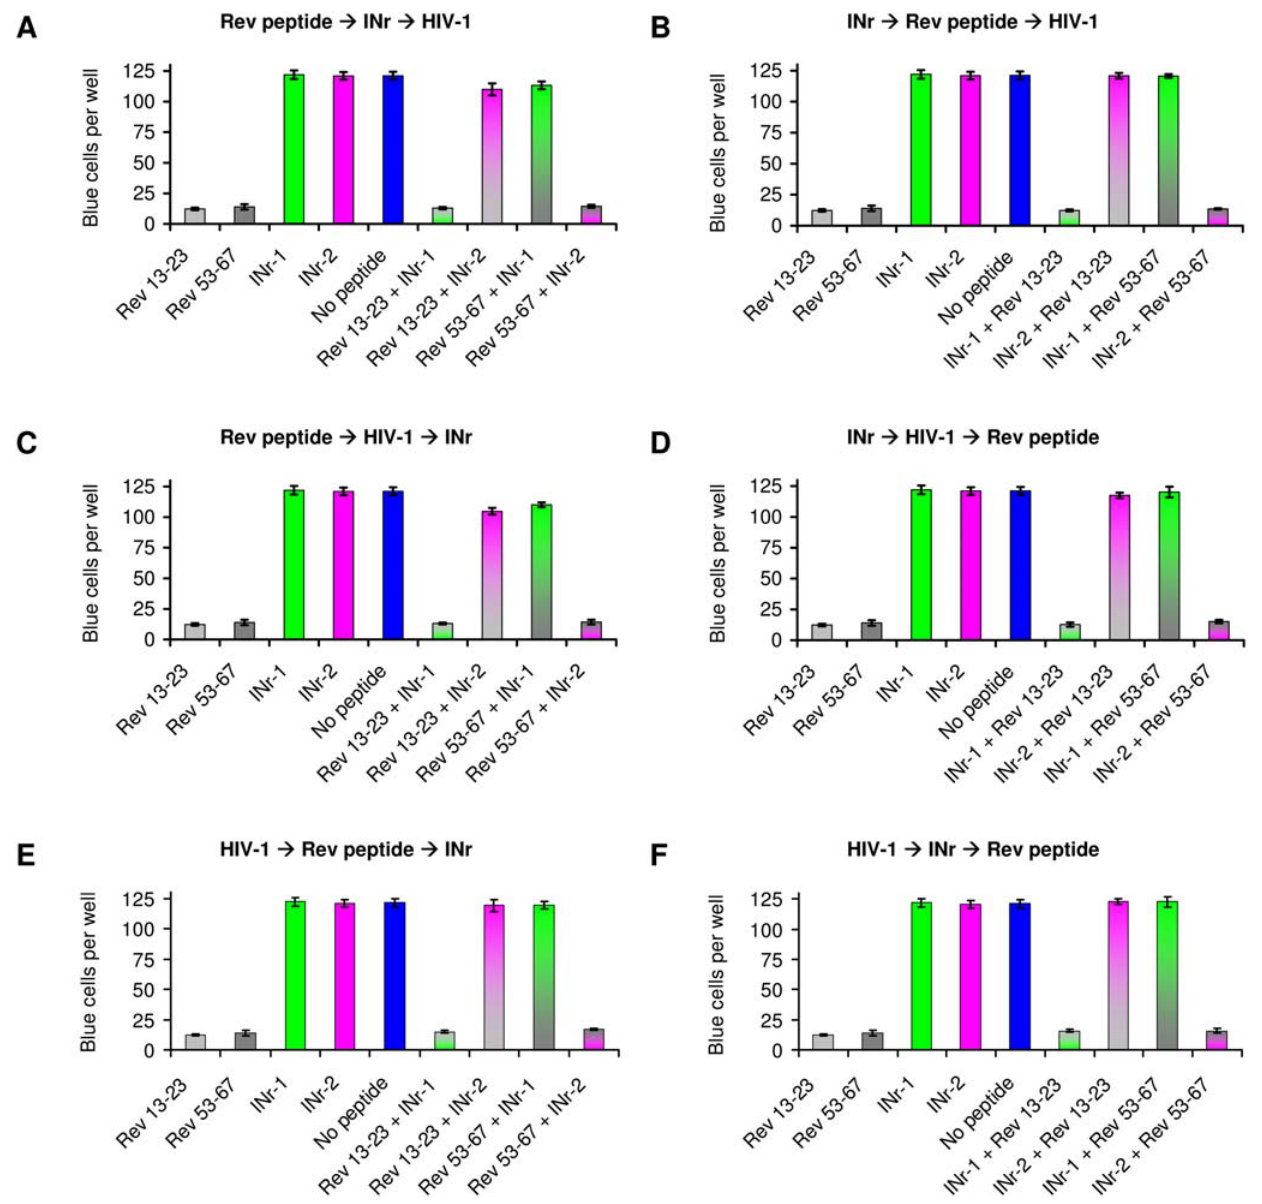
Figure 5. Inhibition of HIV-1 infection by the Rev-derived peptides and abrogation of inhibition by INrs. HeLa MAGI TZM-bl cells were incubated with Rev-derived (12.5 m M of Rev 13–23 or Rev 53–67) and INr (62.5 m M of INr-1 or INr-2) peptides and infected with HIV-1 Delta-env/VSV- G. at different orders of addition as indicated by arrows, A) Rev peptide . INr . HIV-1; (B) INr . Rev peptide . HIV-1; (C) Rev peptide . HIV-1 . INr; (D) INr . HIV-1 . Rev peptide; (E) HIV-1 . Rev peptide . INr; (F) HIV-1 . INr . Rev peptide. Control cells were incubated with none or only one of the indicated peptides. The length of the incubation period with each of the above-described components (HIV-1, Rev and INr peptides) was 2 h at 37 u C and at the end of the total 6-h incubation, the infected cells were left for a further 48-h incubation. At the end of the incubation period, the number of blue cells per well was estimated as described in Materials and Methods. (A summary of the results is presented in Table 3).